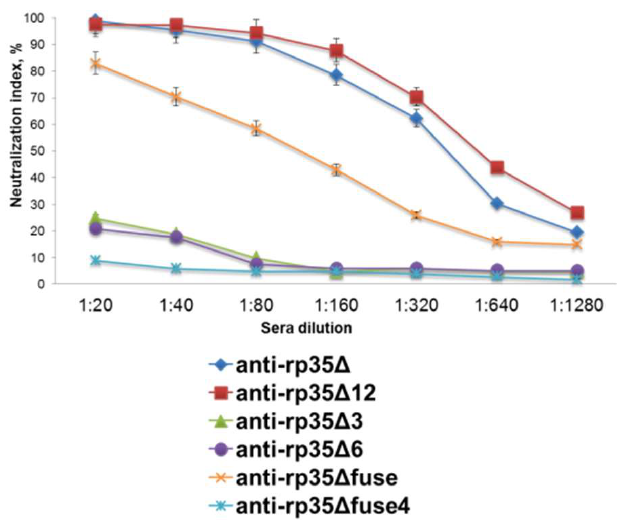
Figure 3. In vitro neutralization of VACV with serial dilutions of pooled anti-rp35Δ, anti-rp35Δ3, anti-rp35Δ6, anti-rp35Δ12, anti-rp35Δfuse, and anti-rp35Δfuse4 sera samples. The initial dilution of sera was 1:20. VACV was diluted to 320 pfu/mL. The data from three or more independent experiments are shown.